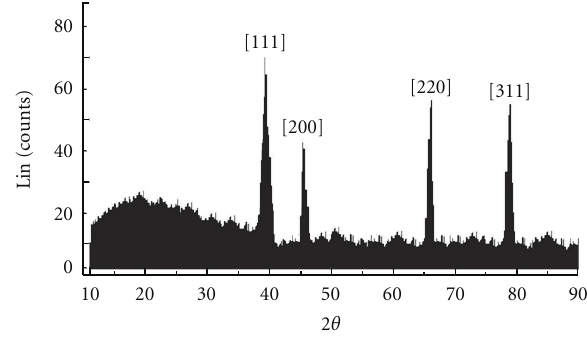
Figure 3: XRD pattern of crystalline AgNPs.